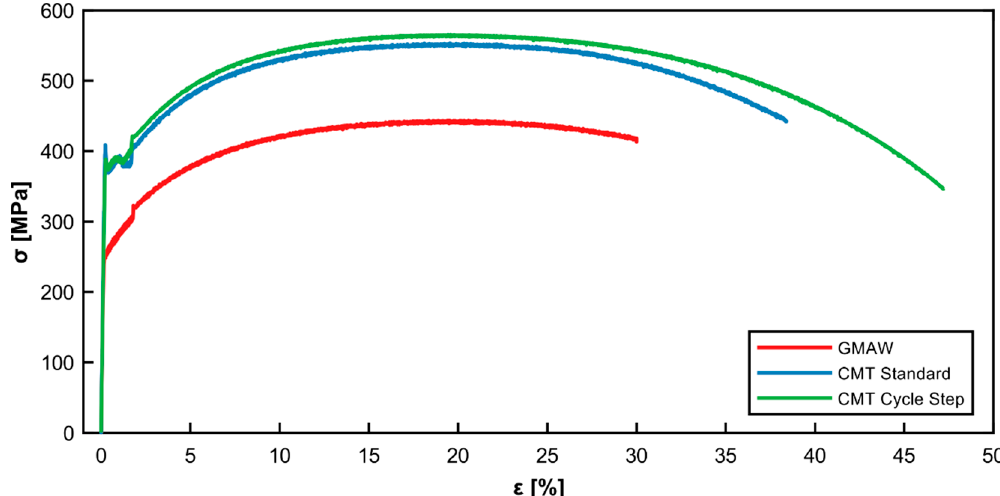
Figure 13. Stress–strain diagram for all three specimens.